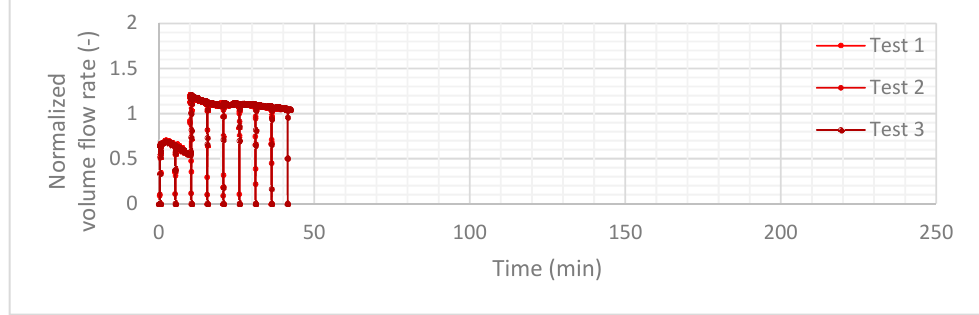
Figure A6. Normalized air volume flow rate trend at a thermostatic temperature of − 10 °C during the three repetitions.